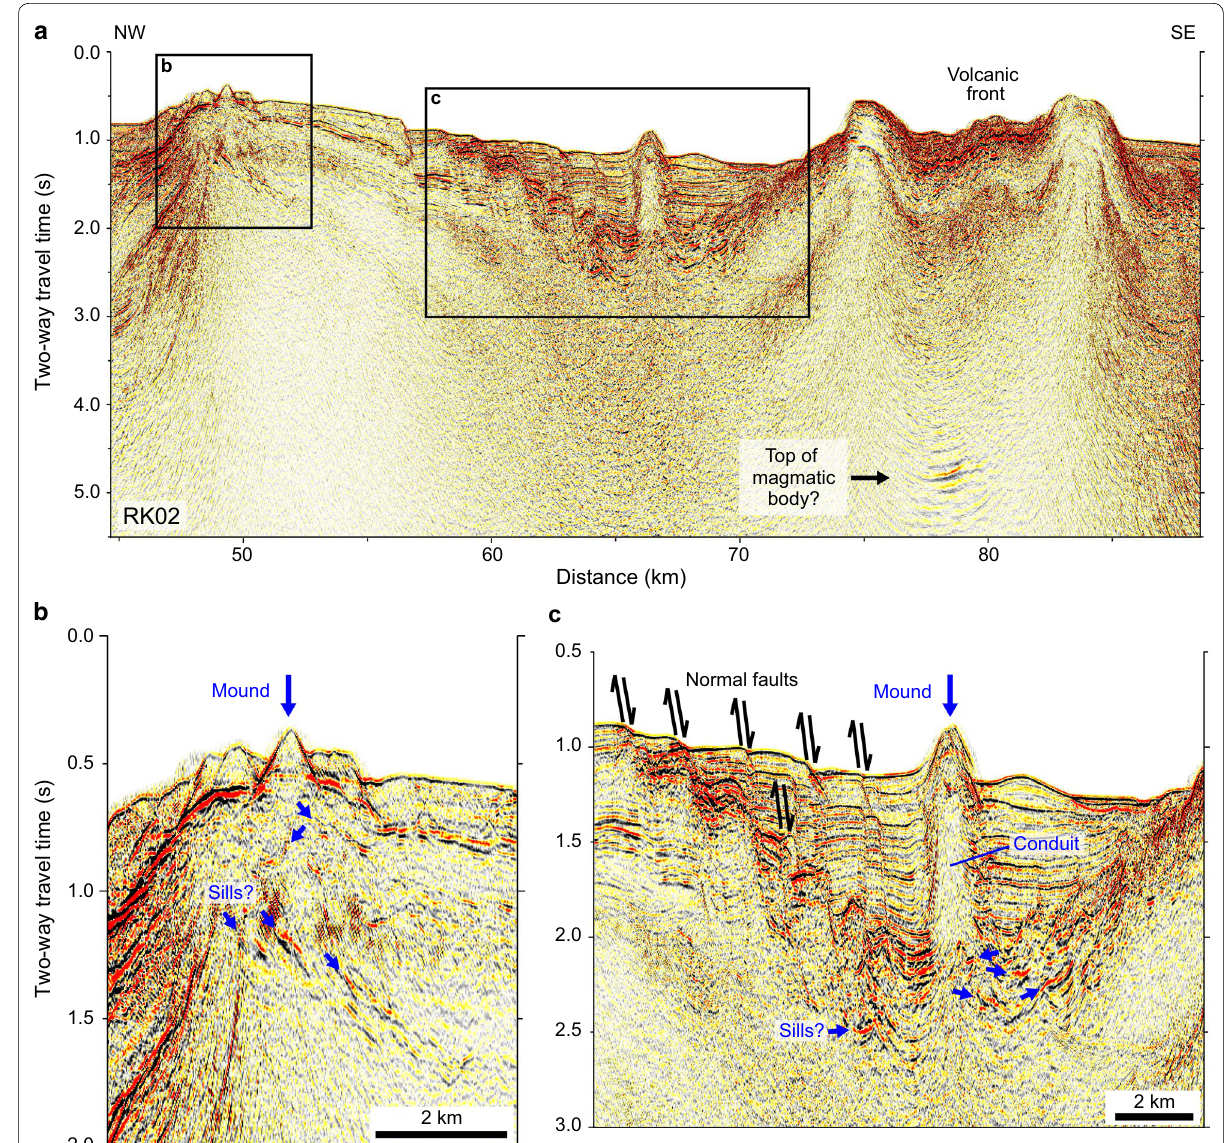
Fig. 6 a Seismic reflection images of the RK02 profile showing magmatic intrusion breaching the seafloor. Here, unlike the RK01 profile (Fig. 5), ~ 1-km-wide transparent bodies indicating volcanic conduits penetrate the shallow crust or sedimentary layers to form obvious volcanic mounds on the seafloor ( b , c ). They are also accompanied by small fragments of seismic reflectors at their roots which are interpreted to be intruded sills (small blue